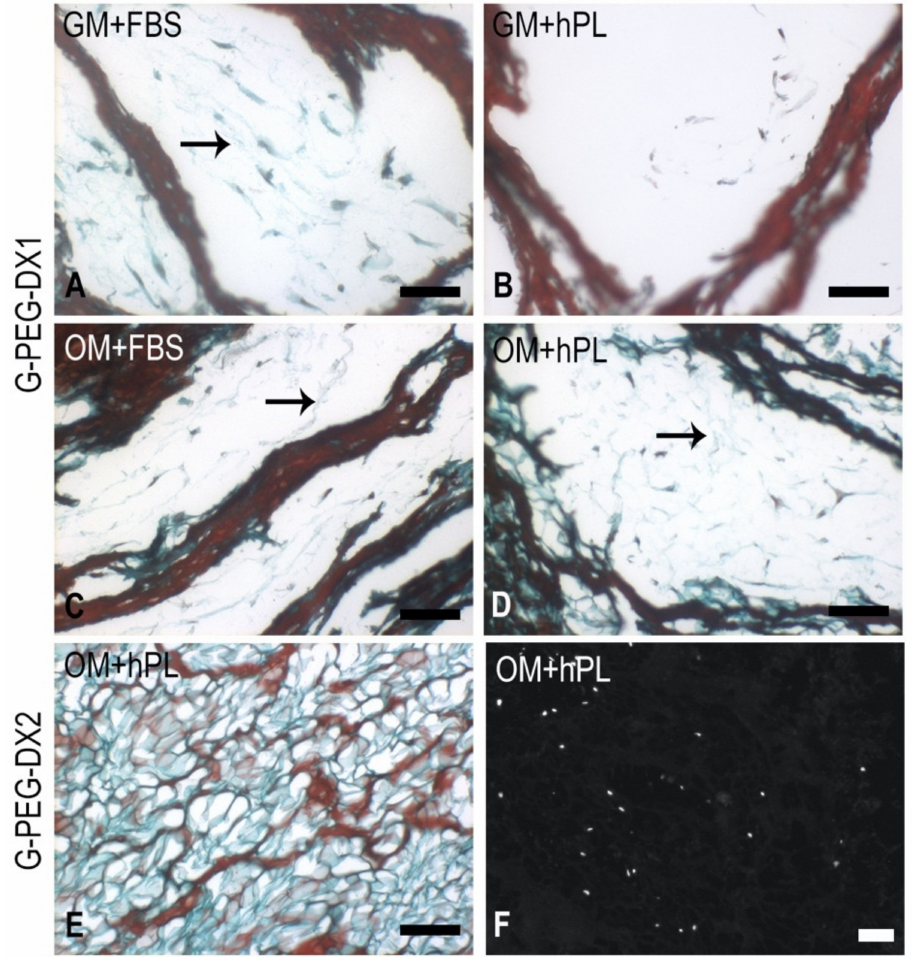
Figure 3. Microphotographs of Masson–Goldner’s Trichrome stain of hydrogels ( A – E ) for extracel- lular matrix deposition and DAPI positive cell nuclei ( F ) for cell colonization. Microphotographs of G-PEG-Dx1 ( A – D ) and G-PEG-Dx2 ( E , F ) under the different culture conditions: GM+FBS ( A ), GM+hPL ( B ), OM+FBS ( C ), OM+hPL ( D – F ). Arrows indicate collagen fibers in light green. Black scale bar: 50 µ m for ( A – E ); white scale bar: 500 µ m for ( F